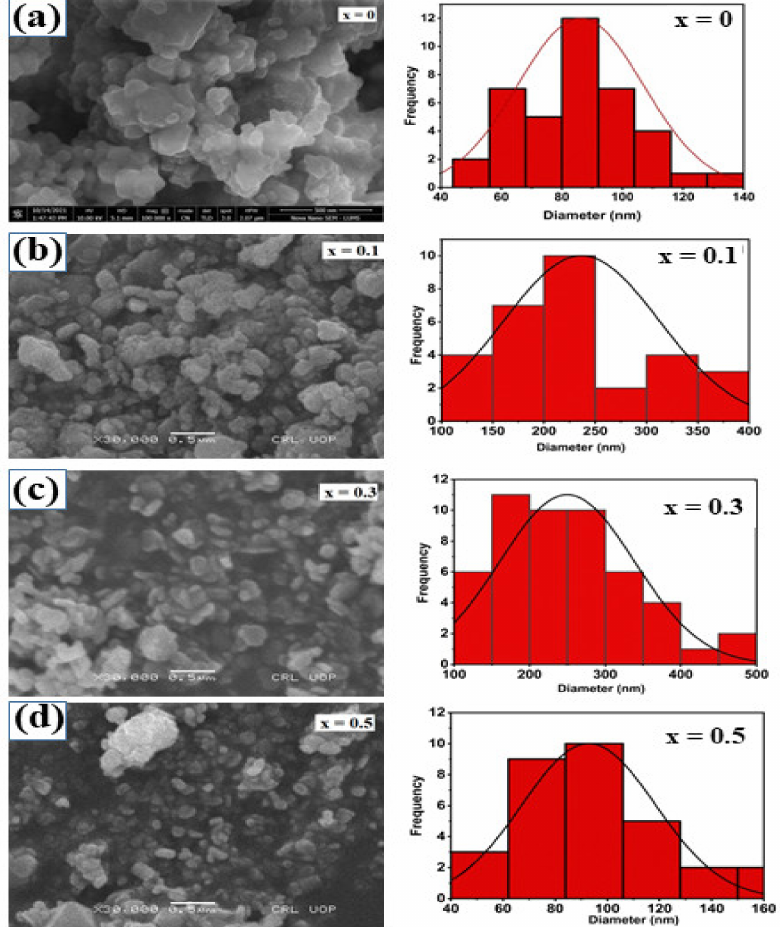
Figure 2. ( a – d ) SEM images and average particle size distribution of pure cobalt ferrite ( a ) x = 0 and Li 1+ /Zn 2+ doped cobalt ferrite ( b ) 0.1, ( c ) 0.3, ( d )